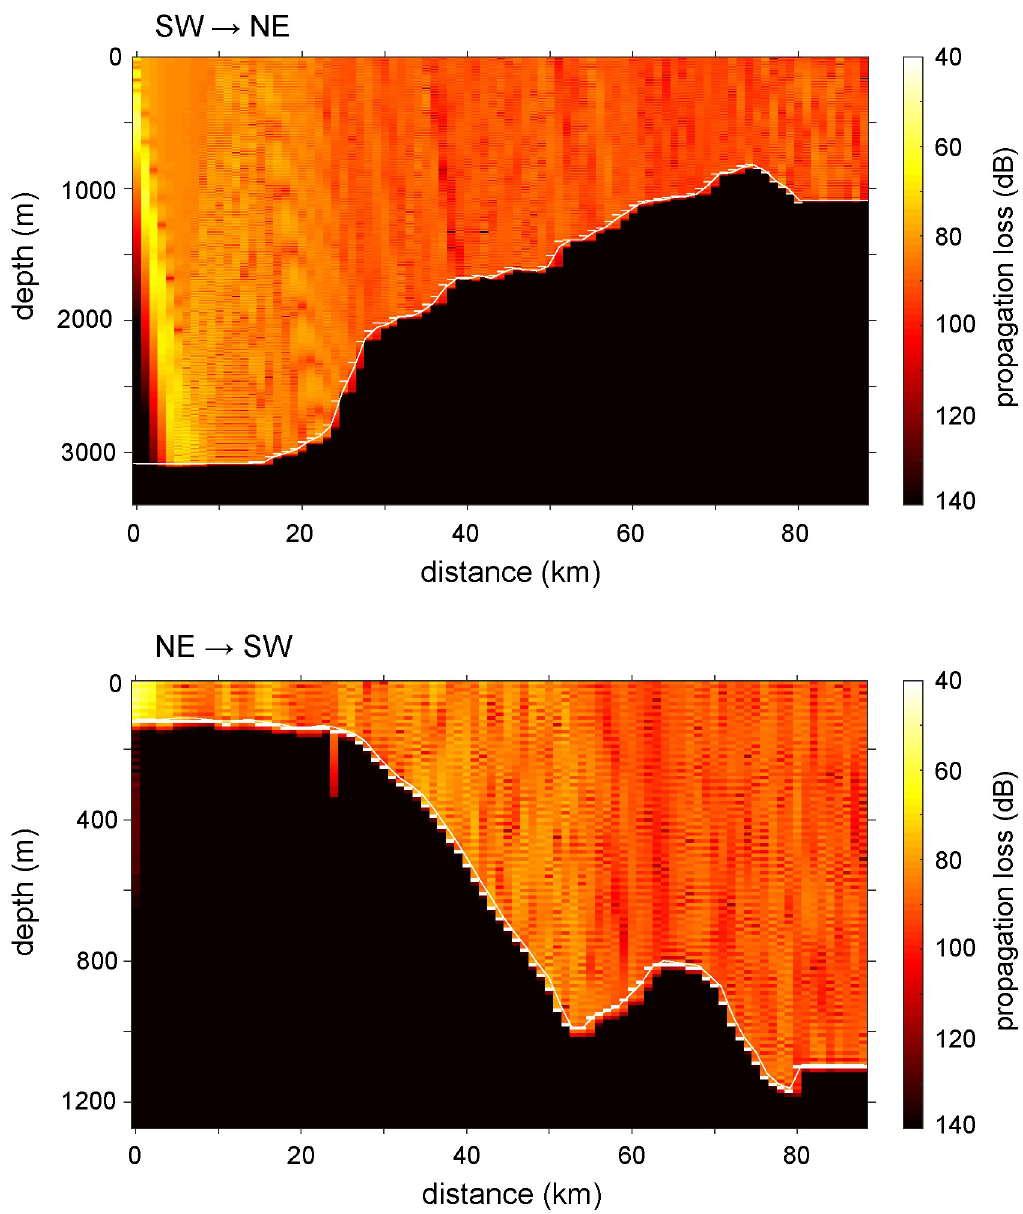
Fig 7. RAM propagation model output for ship noise generated from two vessel positions with respect to the glider ( f = 100 Hz). (upper) Propagation loss from a range of 80 km SW of the glider traveling upslope from deeper water to the continental shelf break near 1000 m depth (lower) Energy loss from a range of 80 km to the NE of the glider propagating down the continental shelf toward the glider position. Sound source originated at 5 m